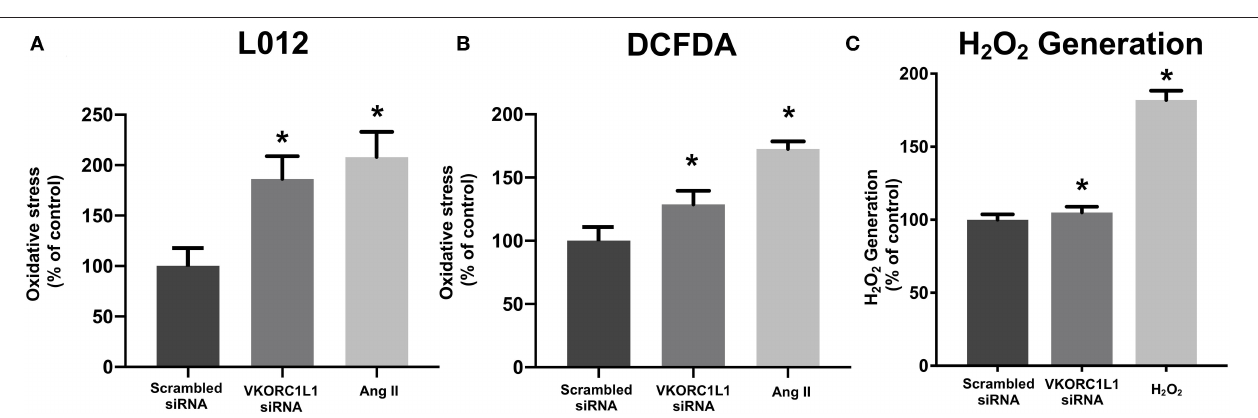
FIGURE 3 | VKORC1L1-inhibition promotes reactive oxygen species formation. (A, B) ROS formation in HCASMC after transfection of siRNAs directed against VKORC1L1 or a scrambled control. Measured by using L-012 (A) and DCFDA assays (B) . Angiotensin II (Ang II) was used as a positive control. n = 6–8. * p < 0.05 (C) H 2 O 2 Generation in HCASMC was measured by an Amplex TM Red assay after transfection with siRNA against VKORC1L1 or a scrambled control. Treatment with H 2 O 2 was used as a positive control. n = 6. * p < 0.05. Data are presented as the mean ± SEM; * p < 0.05; one-way ANOVA + Bonferroni’s multiple comparison test for (A-C)